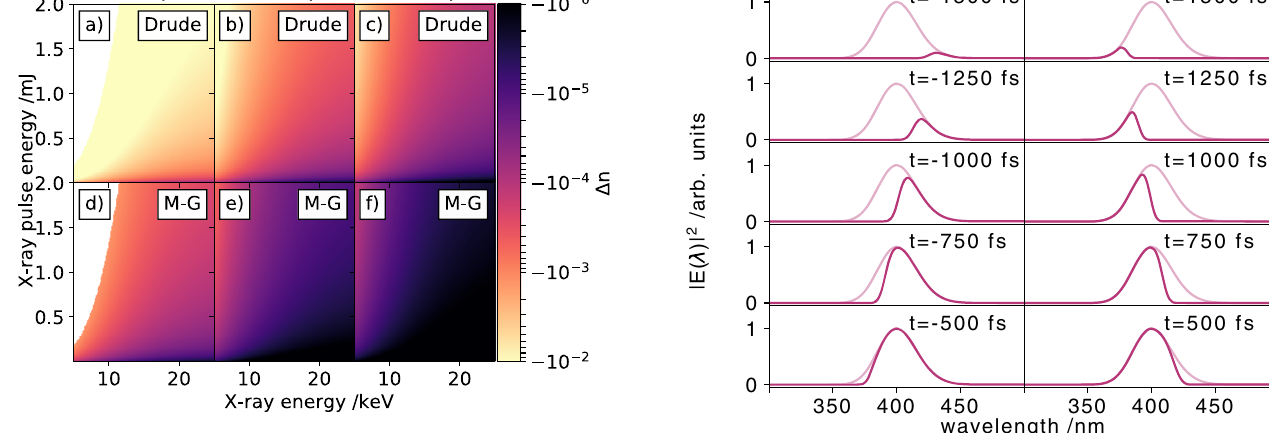
Fig. 3 | Calculated X-ray induced refractive index change. Change of the refractiveindexina50 μ mthickdiamondsamplefordifferentX-raypulseenergies of a broad range of X-ray photon energies. Sub fi gures ( a – c ) show the expected refractive index change for X-ray pulses with a full-width at half maximum beam diameters of d =20 μ m, d =100 μ m and d =200 μ m, calculated with the Drude model. Correspondingly ( d – f ) illustrate the expected refractive index changes calculated with the Maxwell-Garnett (M-G) theory. For details see text.